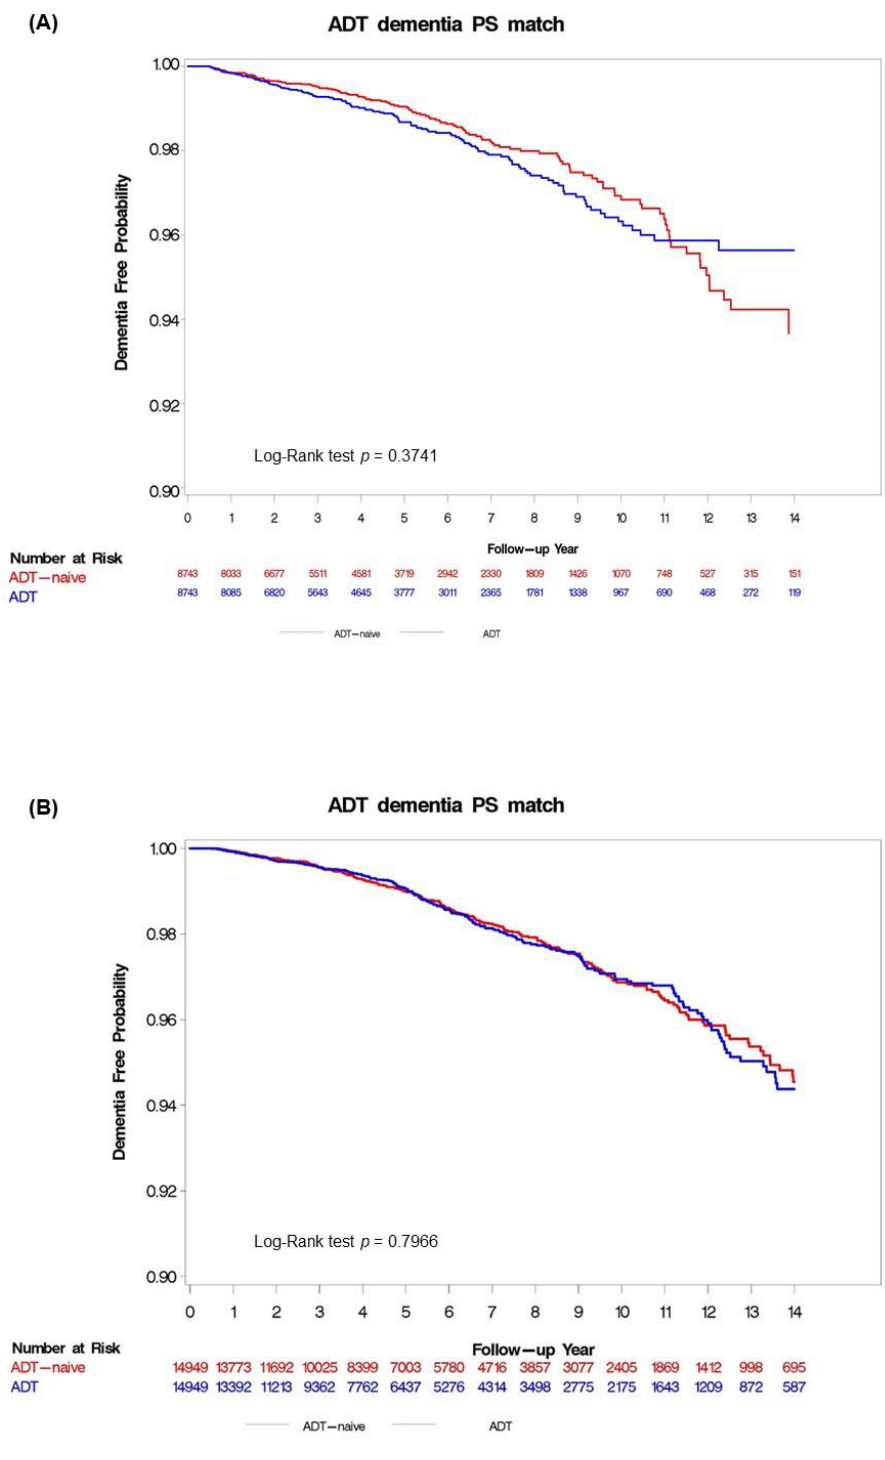
Figure 2. Kaplan–Meier curves according to androgen deprivation therapy (ADT) use for the cumu- lative probability of remaining dementia-free in the propensity score-matched analysis: ( A ) Taiwan; and ( B ) UK. ADT: androgen deprivation therapy; PS: propensity score; UK: United Kingdom.